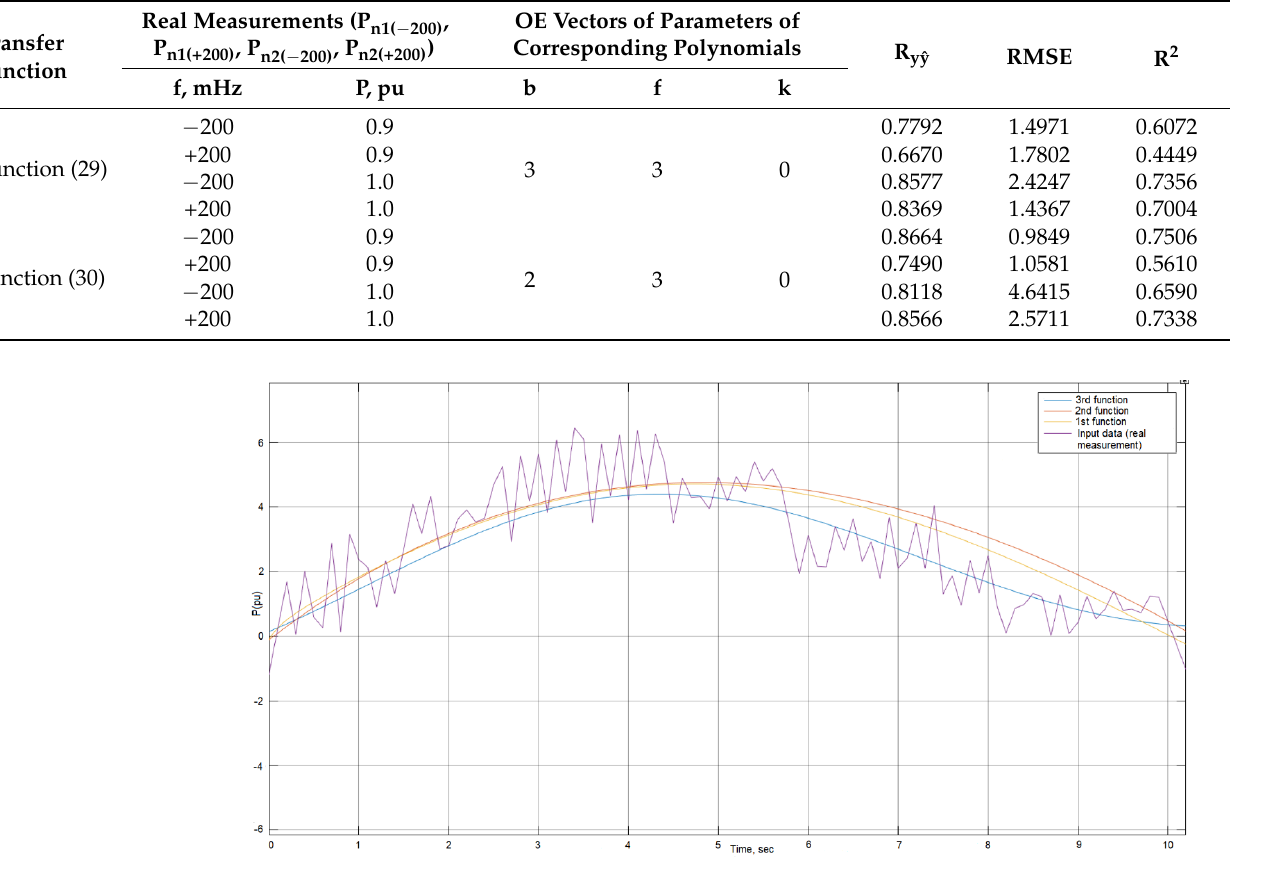
Figure 6. Comparing the real measurement P n1( −2 00) and the functions in (28) – (30), when the frequency deviates by −2 00 mHz. The output data of research model (Figure 5) in square No. 2 “Real measurement output” and No. 3 “Output of the transfer functions” were used to calculate the R yŷ , RMSE, and R 2 coefficients. Real-time measurements (P n1( −2 00) , P n1(+200) , P n2( −2 00) , P n2(+200) ) and transfer functions (28) – (30) were used. The calculated results are presented in Table 2. Table 2. R yŷ , RMSE, and R 2 coefficients of continuous transfer functions obtained by the OE model, when actual measurements, at ± 200 mHz frequency deviation (P n1( −2 00) , P n1(+200) , P n2( −2 00) , P n2(+200) ), were used.